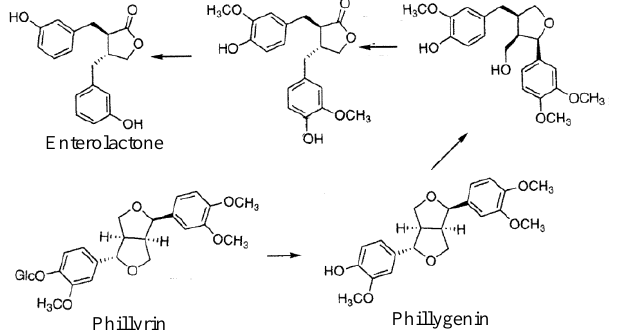
Figure 12. Estimated pathway of the metabolism of phillyrin to enterolactone by intestinal bacteria.